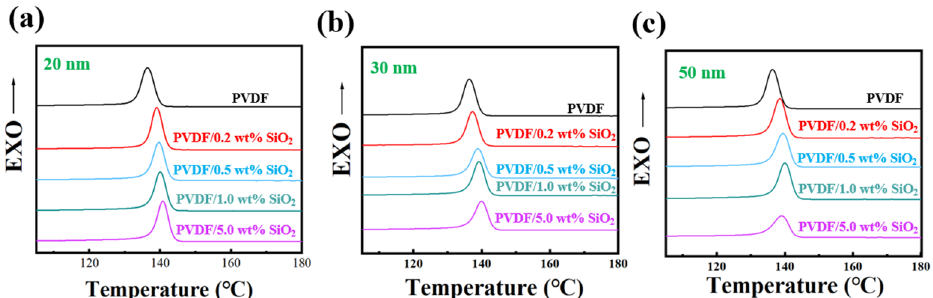
Figure 6. The heat flow curve of PVDF/SiO 2 nanocomposites with different particle sizes and contents during the cooling process. ( a ) 20 nm ( b ) 30 nm ( c ) 50 nm.